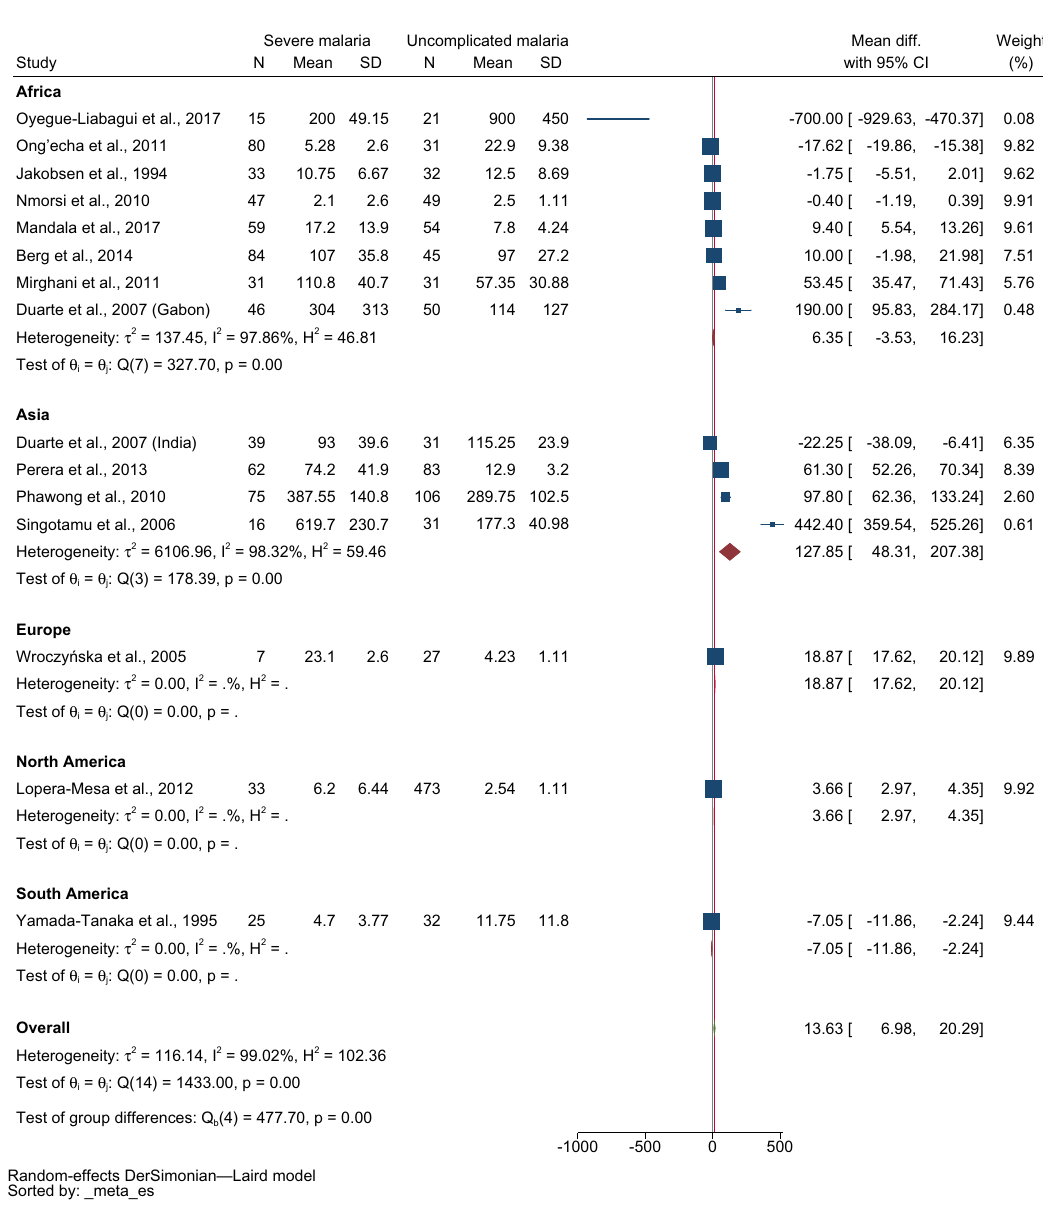
Figure 5. Forest plot demonstrating the pooled MD of INF-γ levels between patients with severe and uncomplicated malaria stratified by location (continent). CI confidence interval, SD standard